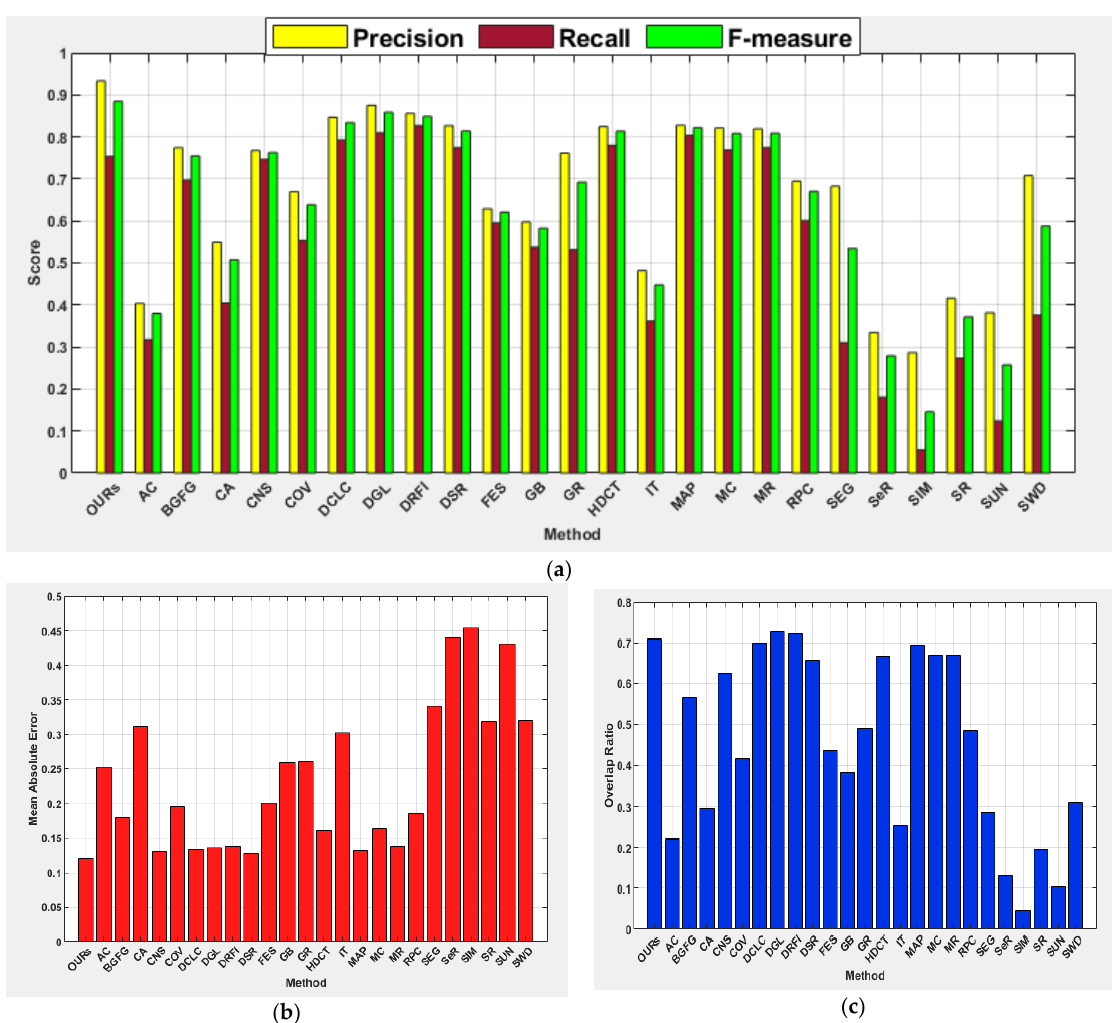
Figure 7. ( a ) F-measure; ( b ) MAE and ( c ) OR on image category: Complex background.